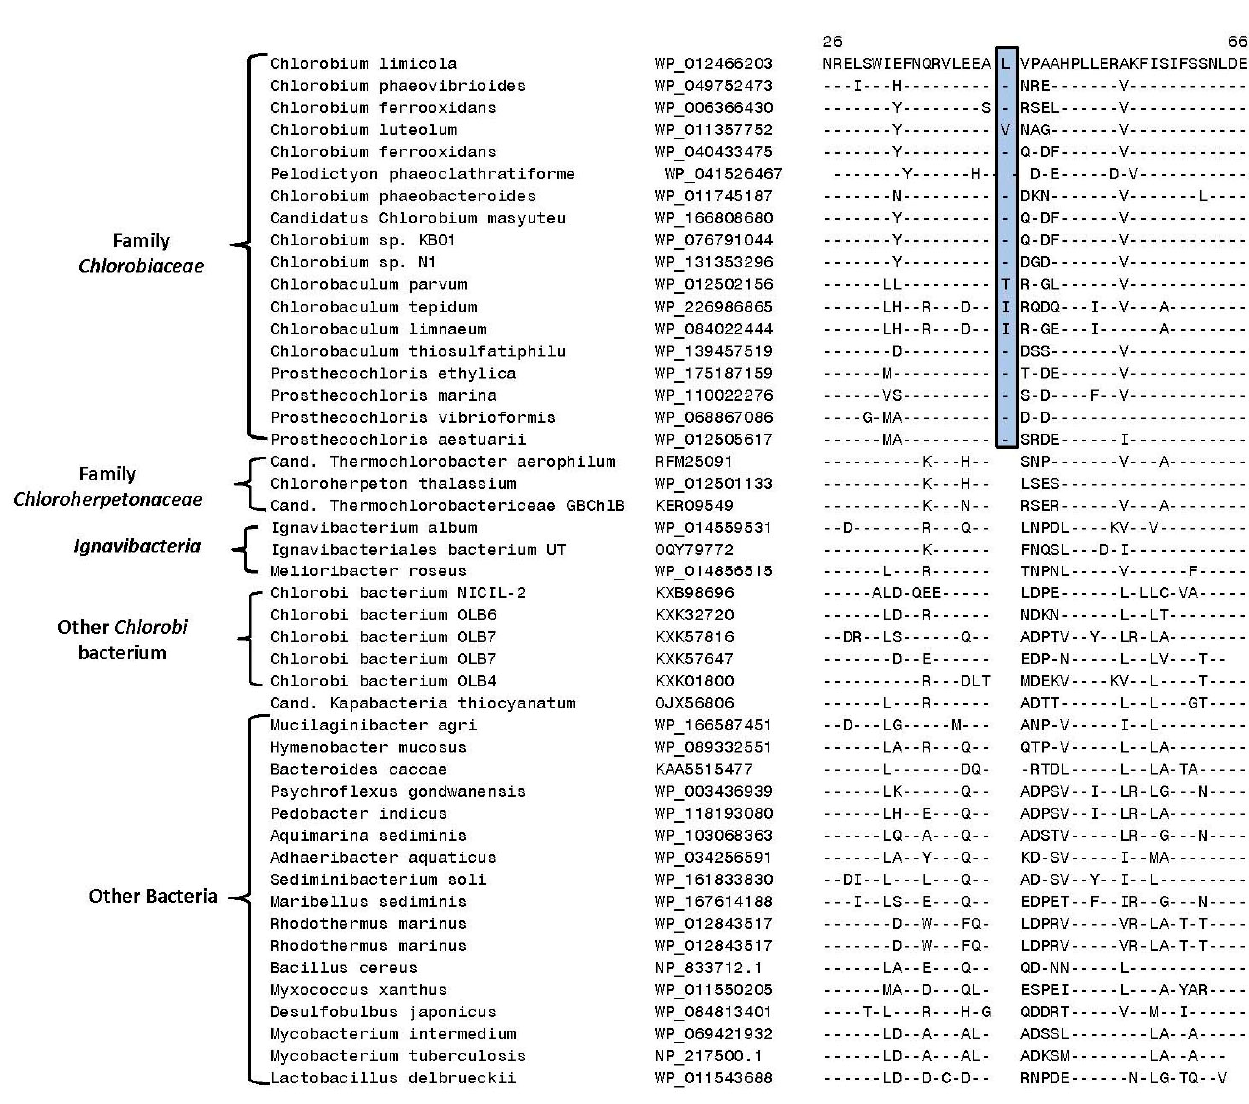
Figure 5. Excerpts from the sequence alignment of the protein polyphosphate kinase highlighting a one-amino-acid insertion (boxed) in a conserved region that is specifically shared by species/strains that are part of the family Chlorobiaceae (Figure 1). This insert is not found in members of the family Chloroherpetonaceae , class Ignavibacteria , other outgroup bacteria, as well as in other Candidatus and Chlorobi bacteria strains that do not group with the Chlorobia clade.